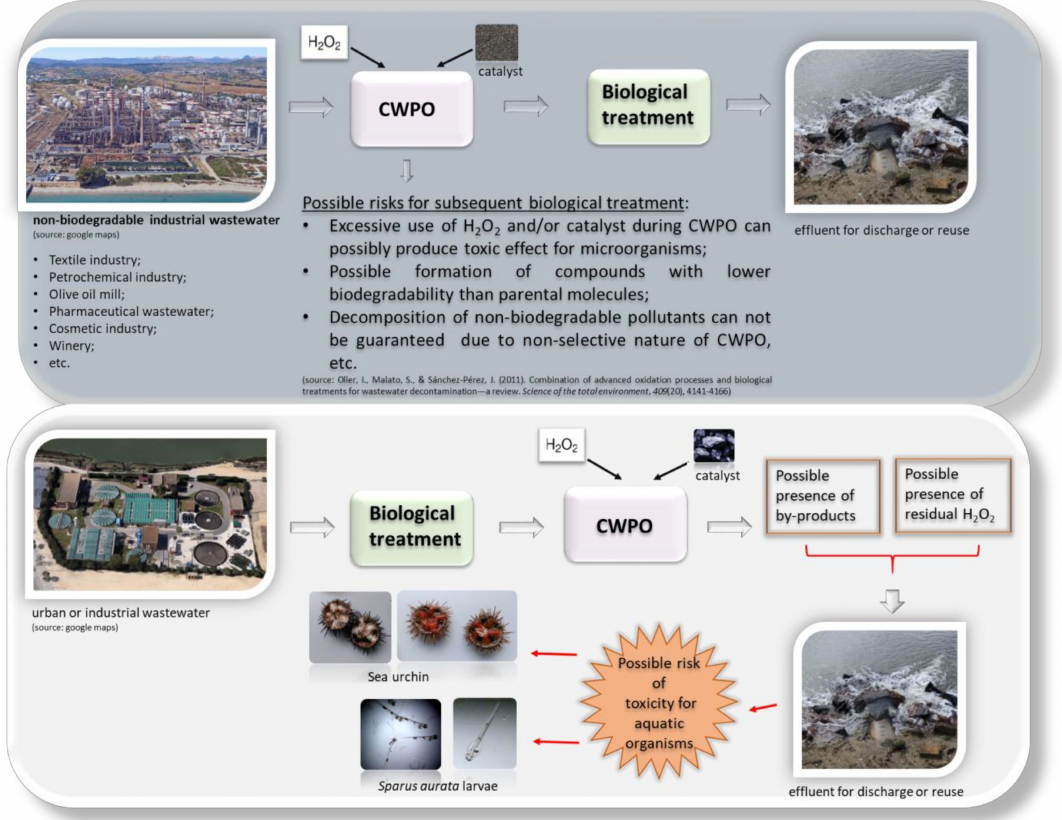
Figure 3. Schematic diagram showing possible integration of CWPO into the wastewater treatment process and potential